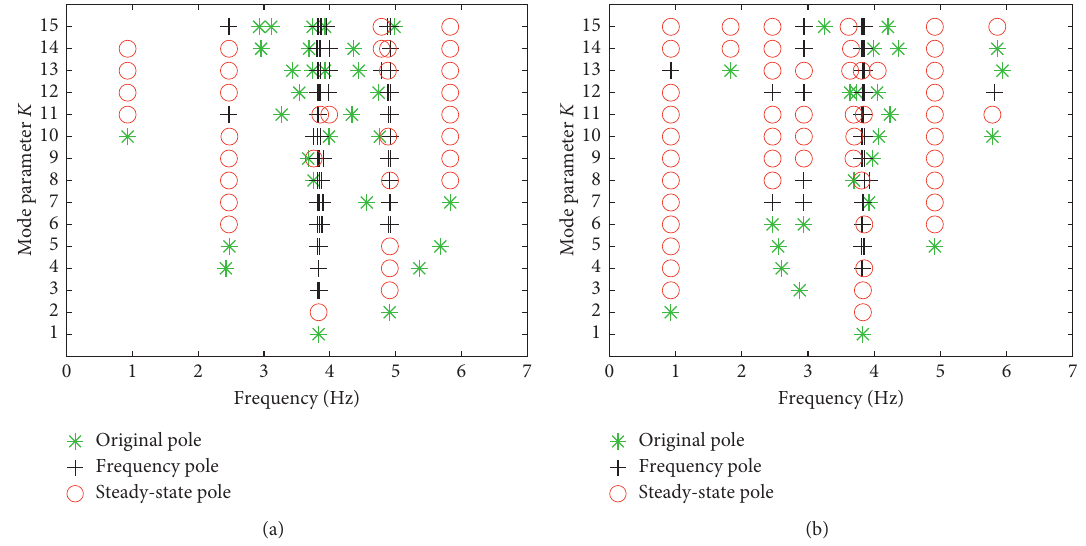
Figure 8: The steady-state poles diagram of mode parameter K in the time-varying model. (a) DOF1. (b)